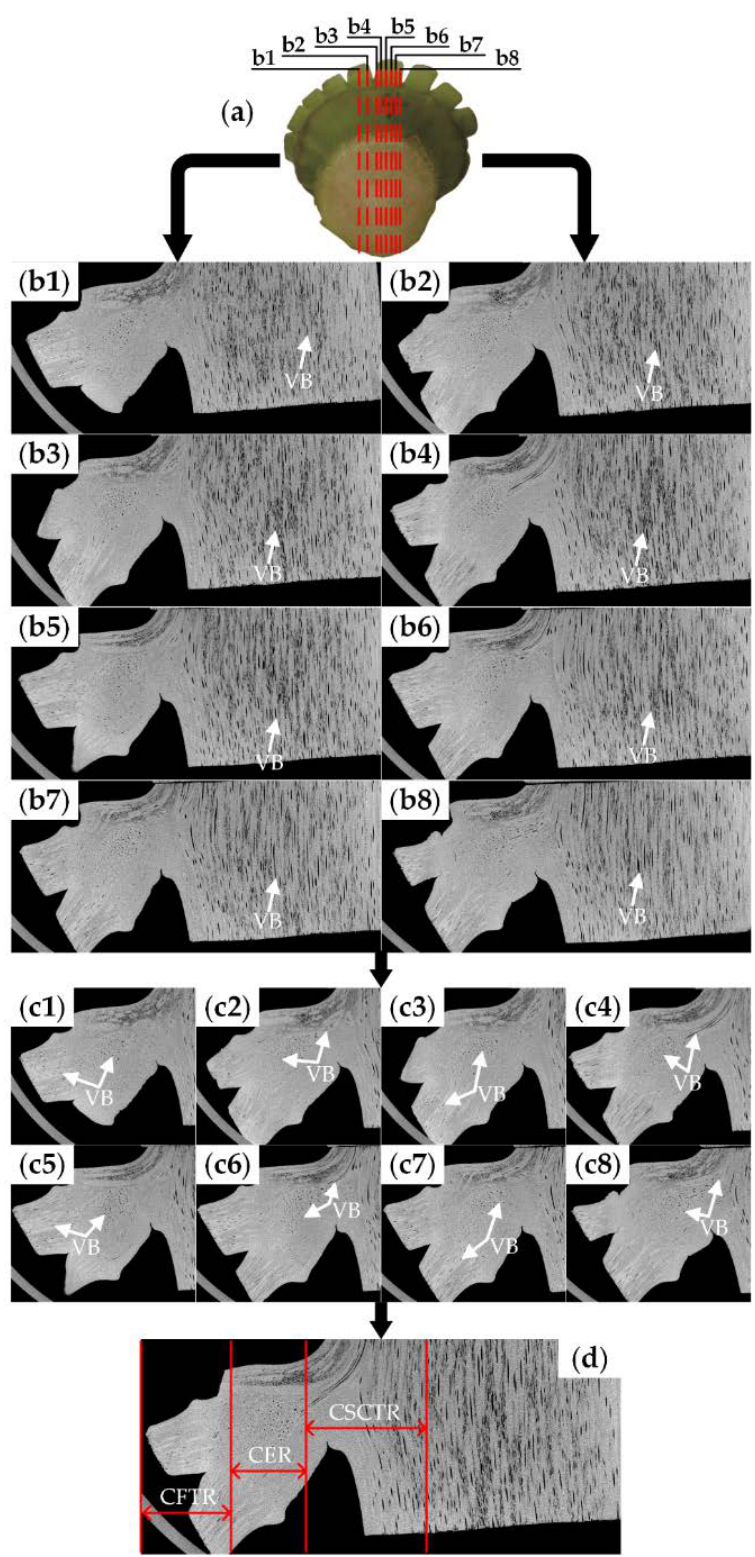
Figure 4. CT cross-sectional images of the crown. ( a ) Top view of the crown. The red lines b1–b8 on the crown indicate the selected observation regions; ( b1 – b8 ) are CT images of the entire selected regions; ( c1 – c8 ) are enlarged images of the crown region of ( b1 – b8 ); ( d ) shows the three regions (CSCTR, CER, CFTR). VB = Vascular bundle. Resolution = 25.3 μm.